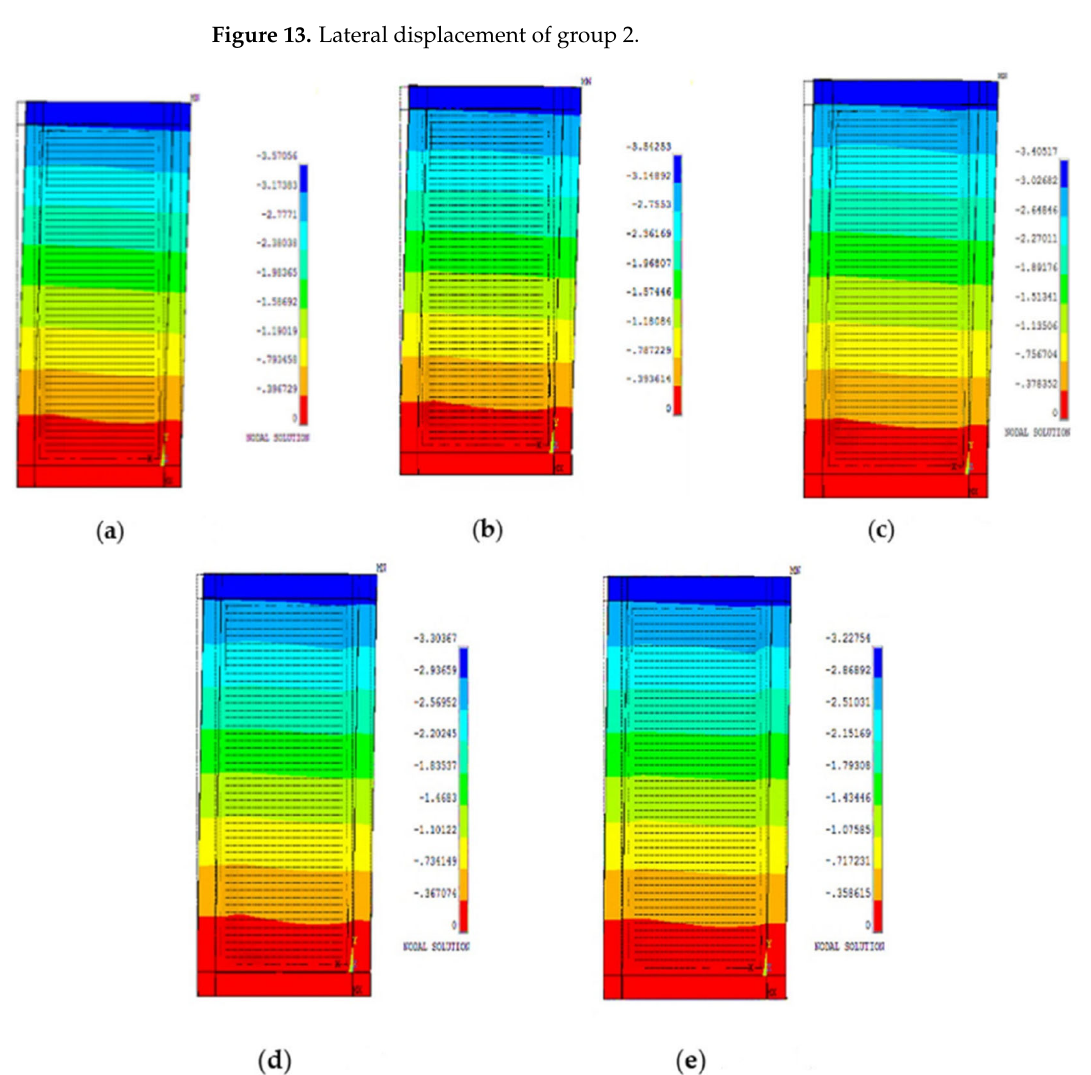
Figure 14. Effect of compressive strength (CS) of concrete on the lateral displacement, ( a ) CS = 25 MPa, ( b ) CS= 28 MPa, ( c ) CS = 45 MPa, ( d ) CS = 50 MPa, ( e ) CS = 55 MPa